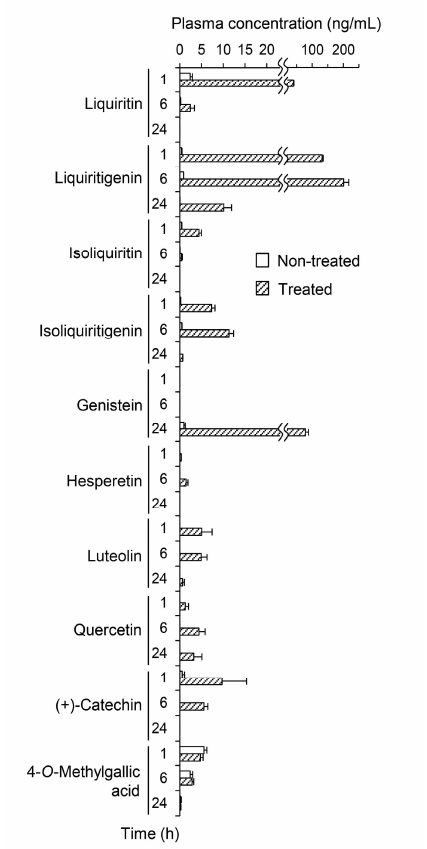
Figure 2. Plasma concentrations of jumihaidokuto (JHT) polyphenols in plasma before and after enzymatic hydrolysis with β -glucuronidase. Plasma samples were obtained at 1, 6, and 24 h after JHT administration to rats (2 g/10 mL/kg). The polyphenol content in the plasma were measured by LC-MS/MS before and after β -glucuronidase treatment. Each data point represents the mean ± S.E. of